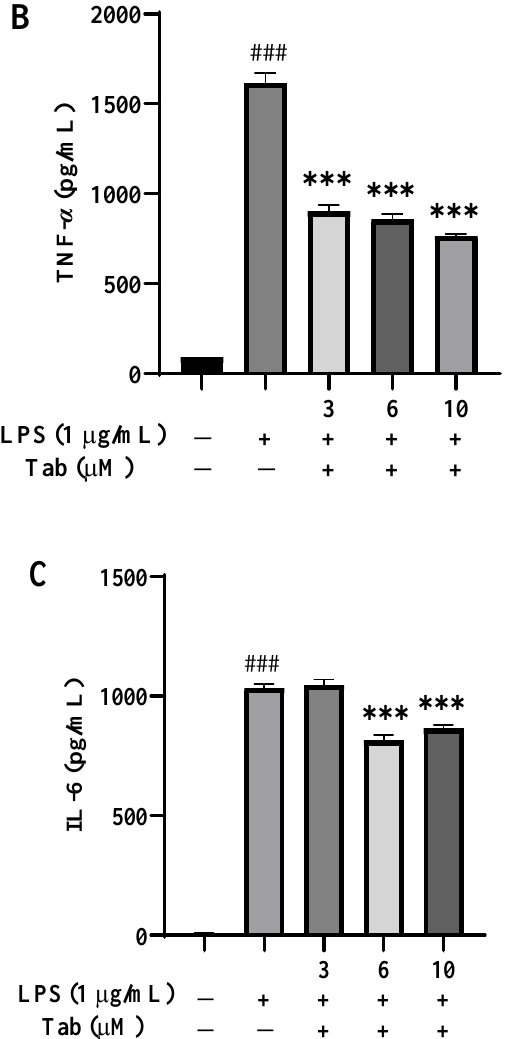
Figure 3. Effect of Tab on the production of IL-1 β , IL-6, and TNF- α in BV2 cells induced by LPS. The cells were pretreated with Tab (3, 6, or 10 µ M) for 4 h, then treated with LPS (1 µ g/mL) for 24 h. The culture supernatant was collected to detect the production of IL-1 β ( A ), TNF- α ( B ), and IL-6 ( C ). ### p < 0.001 vs. untreated control cells and *** p < 0.001 vs. LPS-treated cells.